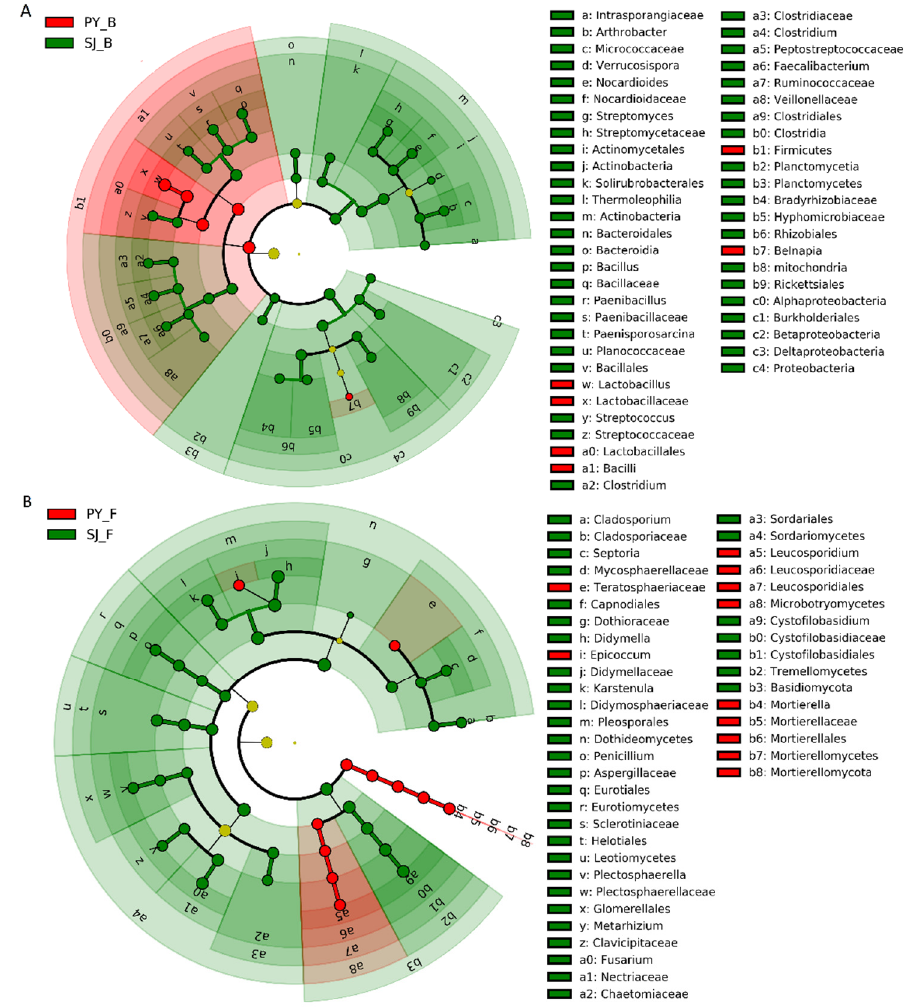
Figure 4. LEfSe analysis of the intestinal bacterial biomarkers ( A ) and fungal biomarkers ( B ) of Hood cranes at Poyang and Shengjin Lake group. Identified phylotype biomarkers were ranked by effect size and the alpha value was < 0.05. Each filled circle represents one biomarker. Cladogram represents the taxonomic hierarchical structure from phylum to genus of the biomarkers identified; Red, phylotypes statistically overrepresented in gut of Hooded Cranes at Poyang Lake; Green, phylotypes statistically overrepresented in gut of Hooded Cranes at Shengjin Lake; Yellow, phylotypes for which relative abundance is not significantly different among three lakes. PY: Poyang Lake; SJ: Shengjin Lake; B: bacteria; F: fungi.